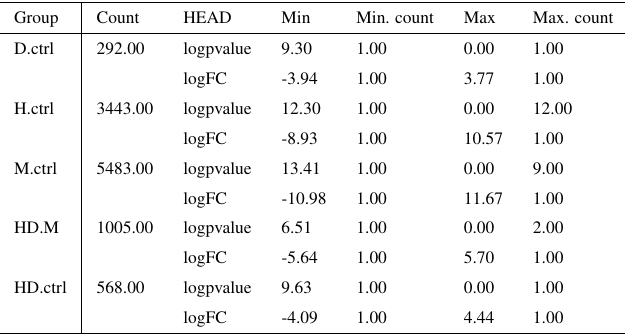
Table 1. The DEGS analysis significance scores for the di ff erent analysis groups as revealed by GEO2R